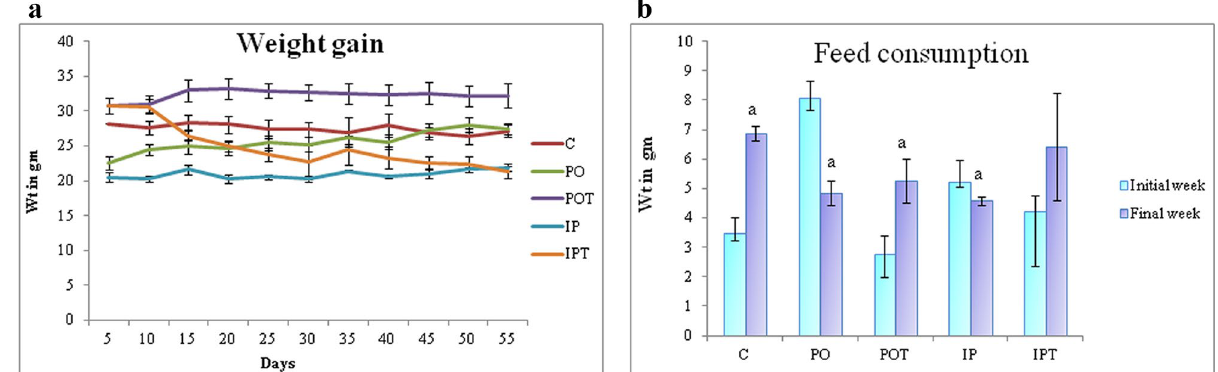
Figure 1. ( a ) Comparison of effect of the TeA and Cin treatment on weight gain of mice over 8 weeks. ( b ) Comparison of the effect of TeA and Cin treatment on feed consumption in the initial and final week of experiment. The results are shown in mean ± SE (‘a’ represents p < 0.005 initial vs final week). Wt in gm is weight in